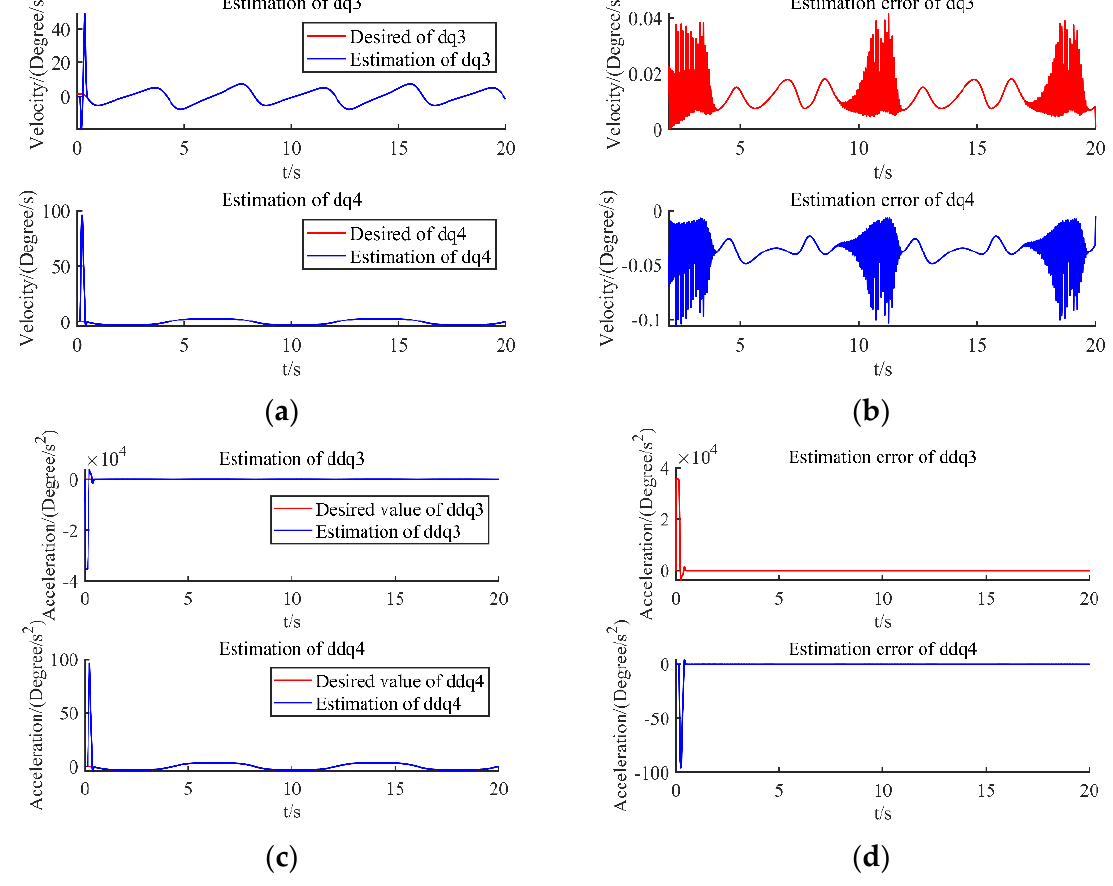
x estimation errors; ( c ) State 3